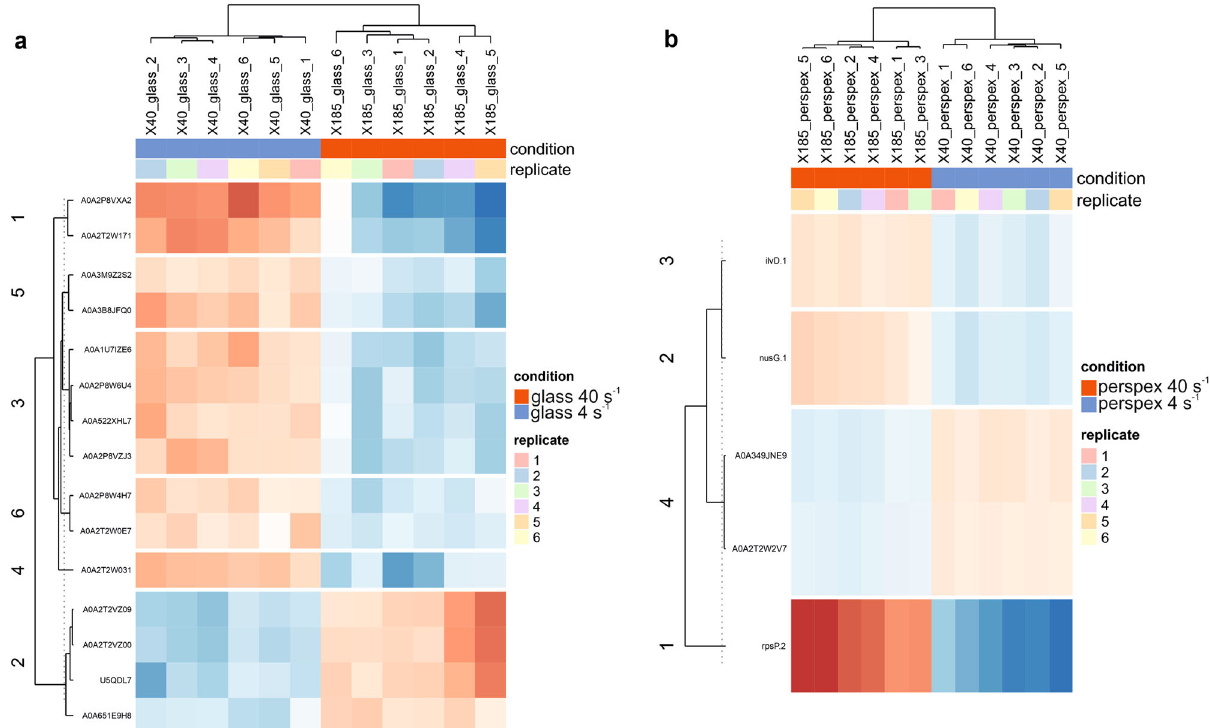
Fig. 5 Heatmaps of the Differentially Expressed Proteins (DEPs) identi fi ed between comparisons of the same surface studied at different hydrodynamics conditions. The fi gures display the DEPs resulting from the comparisons between the conditions ( a ) 4 s − 1 vs . 40 s − 1 on glass clustered in six groups by k-means clustering, and ( b ) 4 s − 1 vs . 40 s − 1 on perspex clustered in four groups. The rows show the corresponding UniProt accession of DEPs with their corresponding expression in the columns as the log 2 fold-change (red: enriched; blue: depleted) of the intensity from each